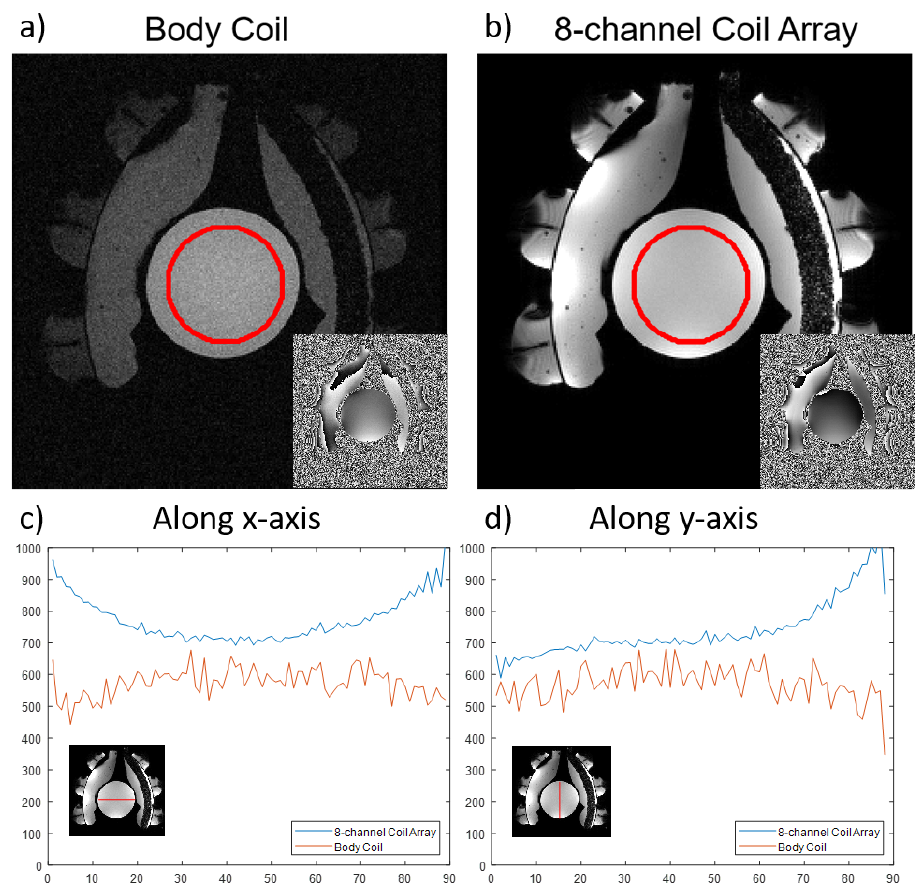
Figure 5. MR magnitude and phase images acquired with ( a ) MR scanner’s body coil ( b ) 8-channel coil array of the MRcollar. The red circle highlights the region of interest where SNR was calculated. Line plots of signal intensities along ( c ) x-axis ( d ) y-axis acquired with the 8-channel coil array (blue) and the body coil